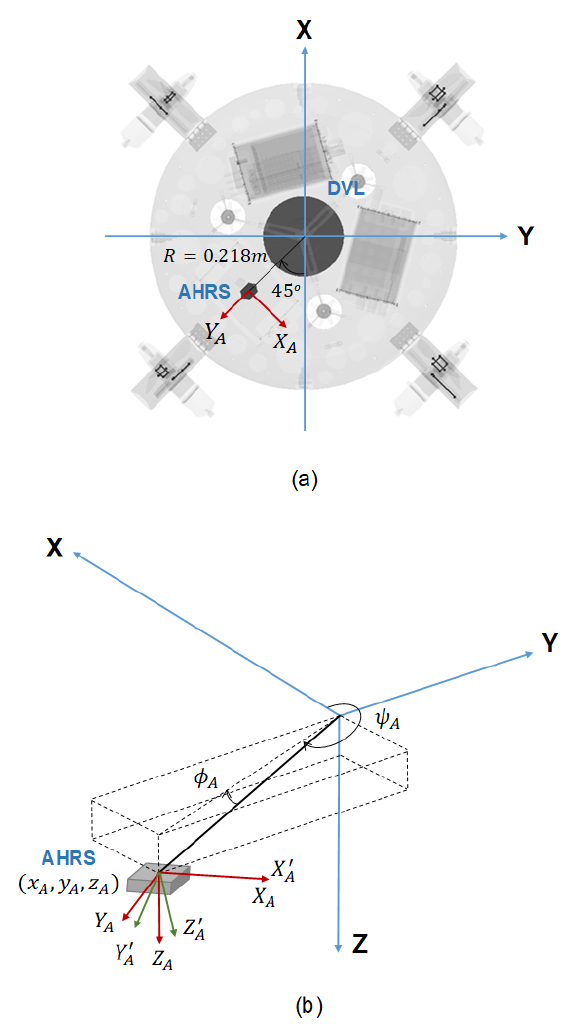
Figure 2. Motion sensor arrangement and lever arm coordinates for the developed vehicle: ( a ) is the motion sensor arrangement; and ( b ) shows the AHRS lever arm